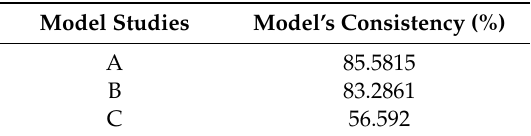
Table 10. Models’